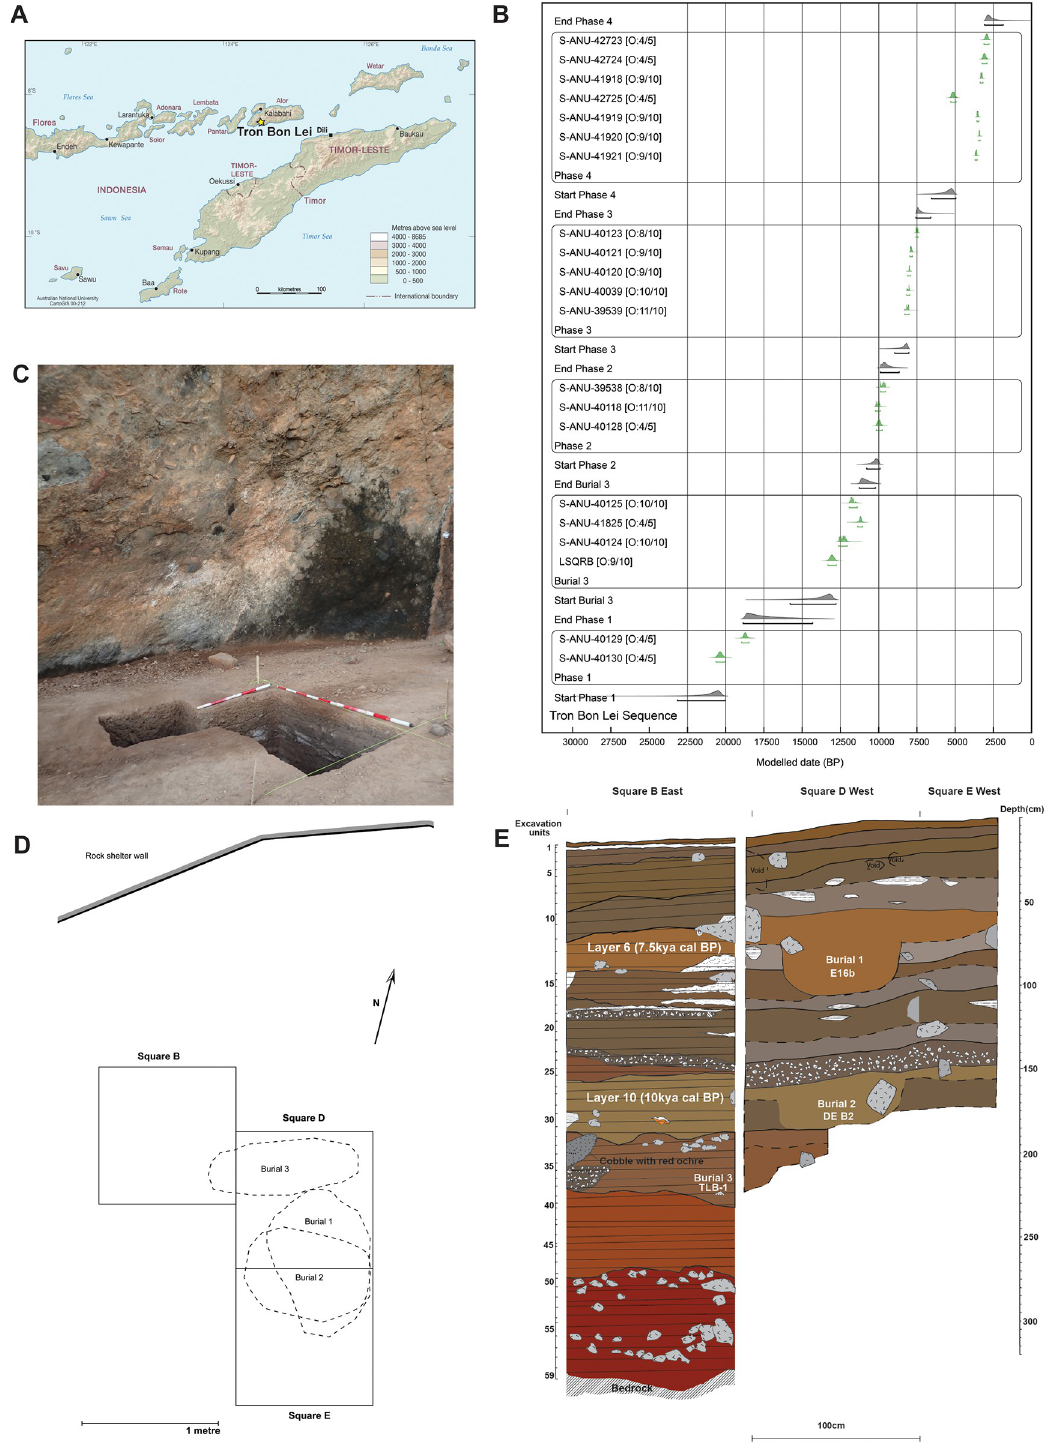
Fig 2. Location, chronology and stratigraphy of Tron Bon Lei. A) Location of Tron Bon Lei on the south coast of Alor. Map reproduced with the permission of the CartoGIS Services, Scholarly Information Services, The Australian National University; B) Bayesian model of dates for Tron Bon Lei, square B. Modelled in OxCal v.4.4. [13] with the Marine20 [14] calibration curve for marine shell samples and a U(0,50) mixed calibration curve with IntCal20 [15] and SHCal20 [16], as recommended for the Inter- Tropical Convergence Zone [16, 17]; C) General view of squares B, D and E; D) Schematic drawing illustrating the morphology of the grave cuts for each of the burials from Tron Bon Lei; E) Combined stratigraphy of squares B, D and E.